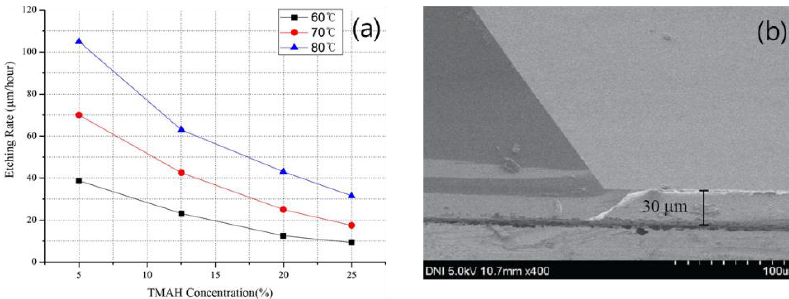
Figure 7. ( a ) Silicon etching rate as a function of tetramethylammonium hydroxide (TMAH) concentration with respect to temperature, and ( b ) etched silicon wafer using TMAH.